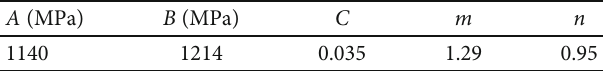
Figure 14: Comparison of experimental results with simulation results. Table 4: The modi fi ed Johnson-Cook material